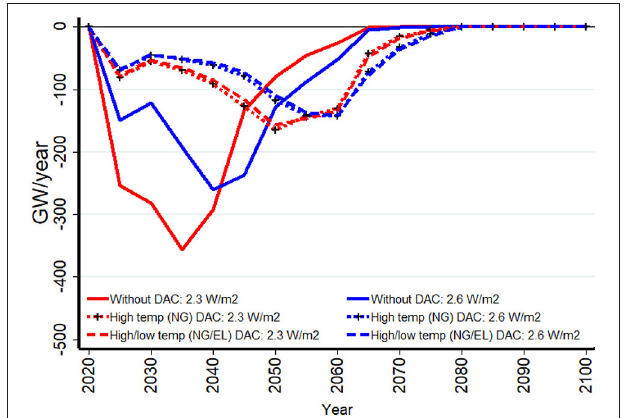
FIGURE 5 | Stranded capacities of existing generation in the global power sector under the least cost strategy scenarios that aim to achieve climate mitigation by limiting total radiative forcing to 2.3 and 2.6 W/m 2 by year 2100, respectively. The scenario “Without DAC” includes only BECCS and AR, the scenario “High temp (NG) DAC” includes a high temperature natural gas-based DAC in addition to BECCS and AR, and the scenario “High/low temp (NG/EL) DAC” includes three types of DAC (high temperature natural gas-based DAC, high temperature electricity-based DAC and low temperature electricity-based DAC) in addition to BECCS and AR.